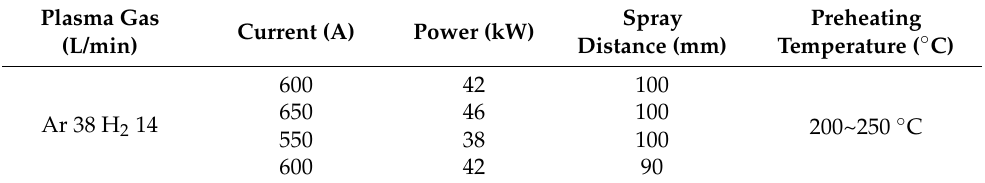
Table 1. Spray parameters of ceramic